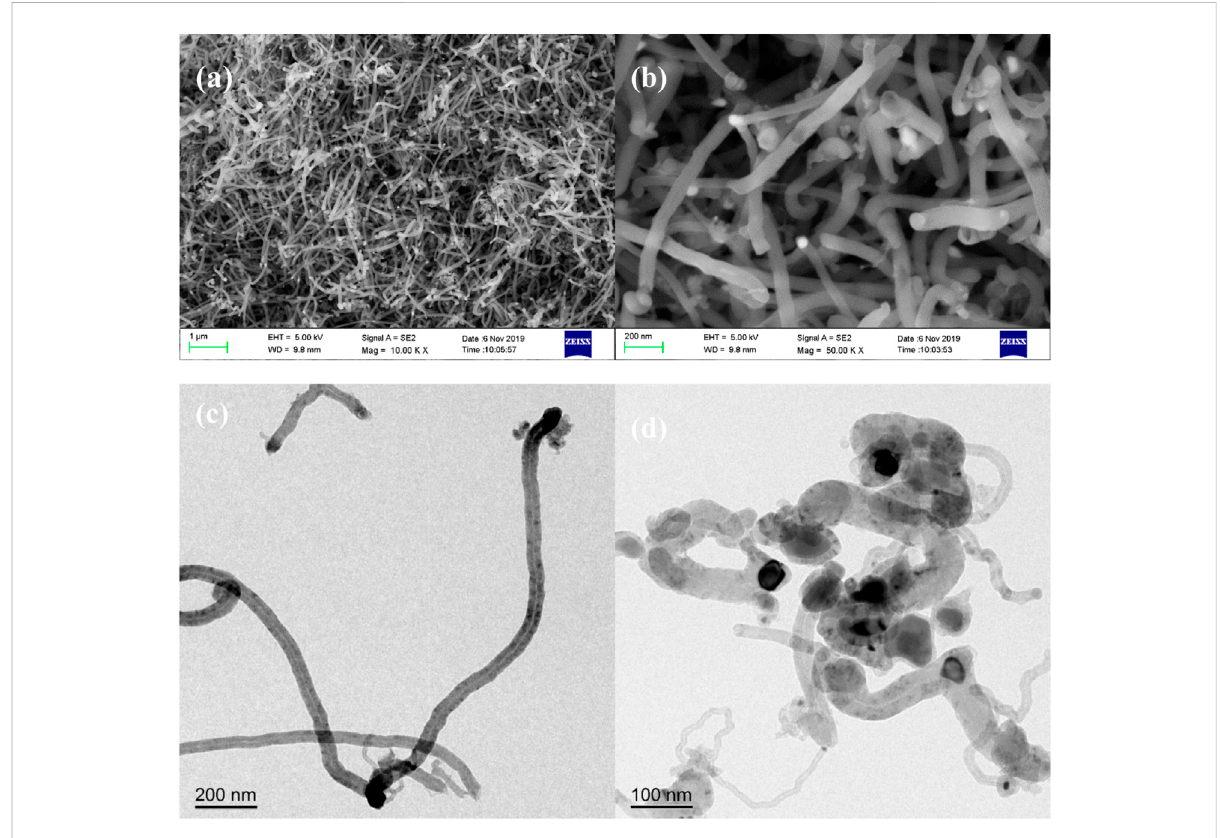
FIGURE 5 SEM (A,B) and TEM (C,D) images of the products derived from nickel acetylacetonate dissolved in benzene at 900